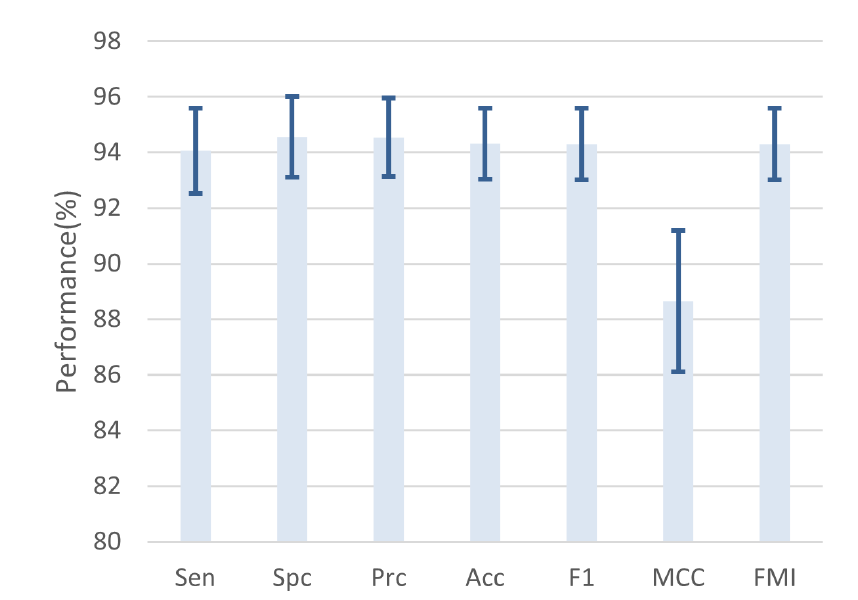
Figure 8. Error bar of max pooling results. Table 7. Results of ten